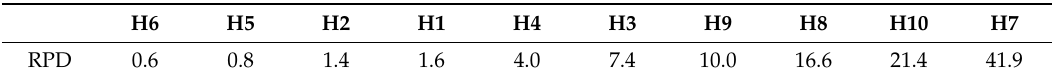
Table 10. Overall performance rankings (average RPD) of heuristics in relation to optimal solution for instances in Group